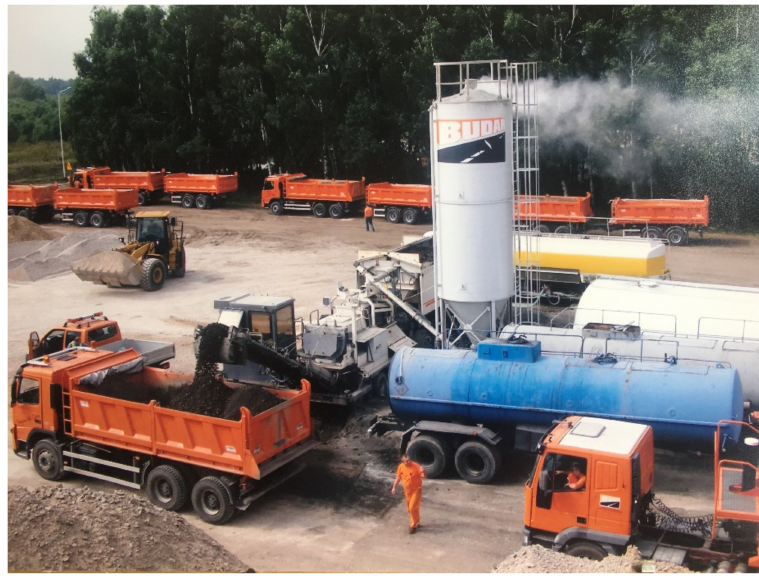
Figure 2. Performing of the MCE mixture using the “in-place” method. [J.